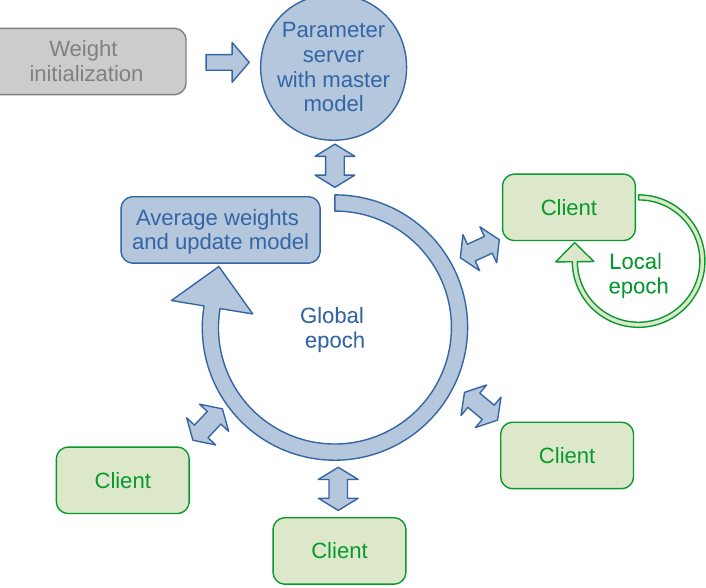
Figure 4. Flowchart of the federated aggregation of the local weight updates into the master